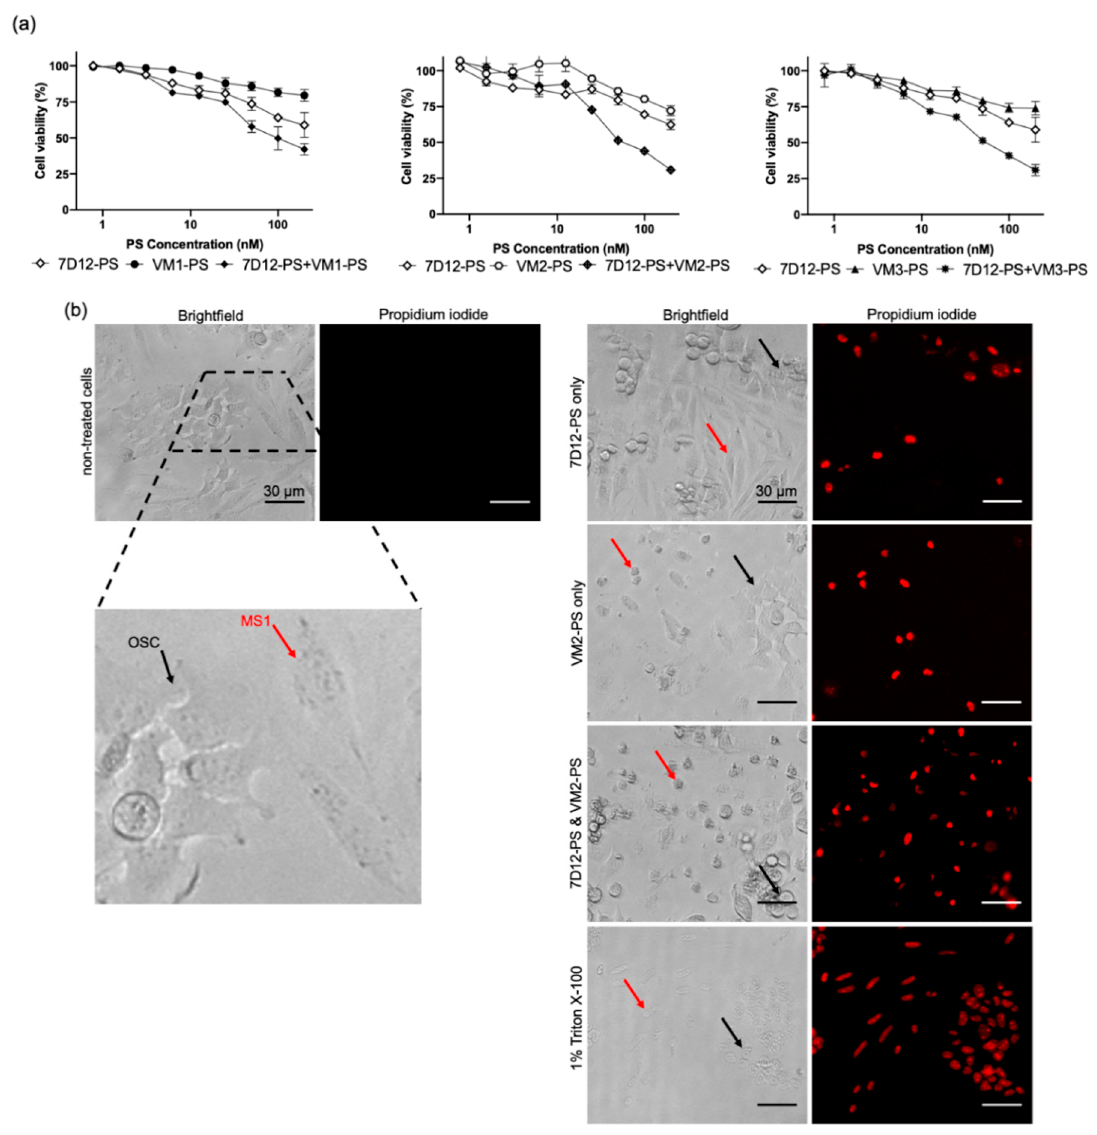
Figure 5. In vitro nanobody-targeted PDT in co-culture of endothelial and cancer cells. ( a ) The percentage of cell viability 24 h after illumination relative to the non-treated cells. Murine endothelial cells (MS1) and human cancer cells (OSC) were co-seeded with 1:3 ratio and incubated with different concentrations of VM–PS conjugates targeting VEGFR2 on endothelial cells, and 7D12–PS targeting EGFR on cancer cells for 1 h at 37 °C, then illuminated with 7 mW/cm 2 fluence rate and a total light dose of 20 J/cm 2 using a 690-nm diode laser through a 600- μ m optic fiber. ( b ) MS1/OSC co-culture treated with VM2–PS (targeting VEGFR2 on MS1) or 7D12–PS (targeting EGFR on OSC cells) or the mixture of both. Dead cells were stained with propidium iodide 24 h after illumination. MS1 and OSC cells shown with red and black arrows, respectively. Scale bar: 30 μ m.